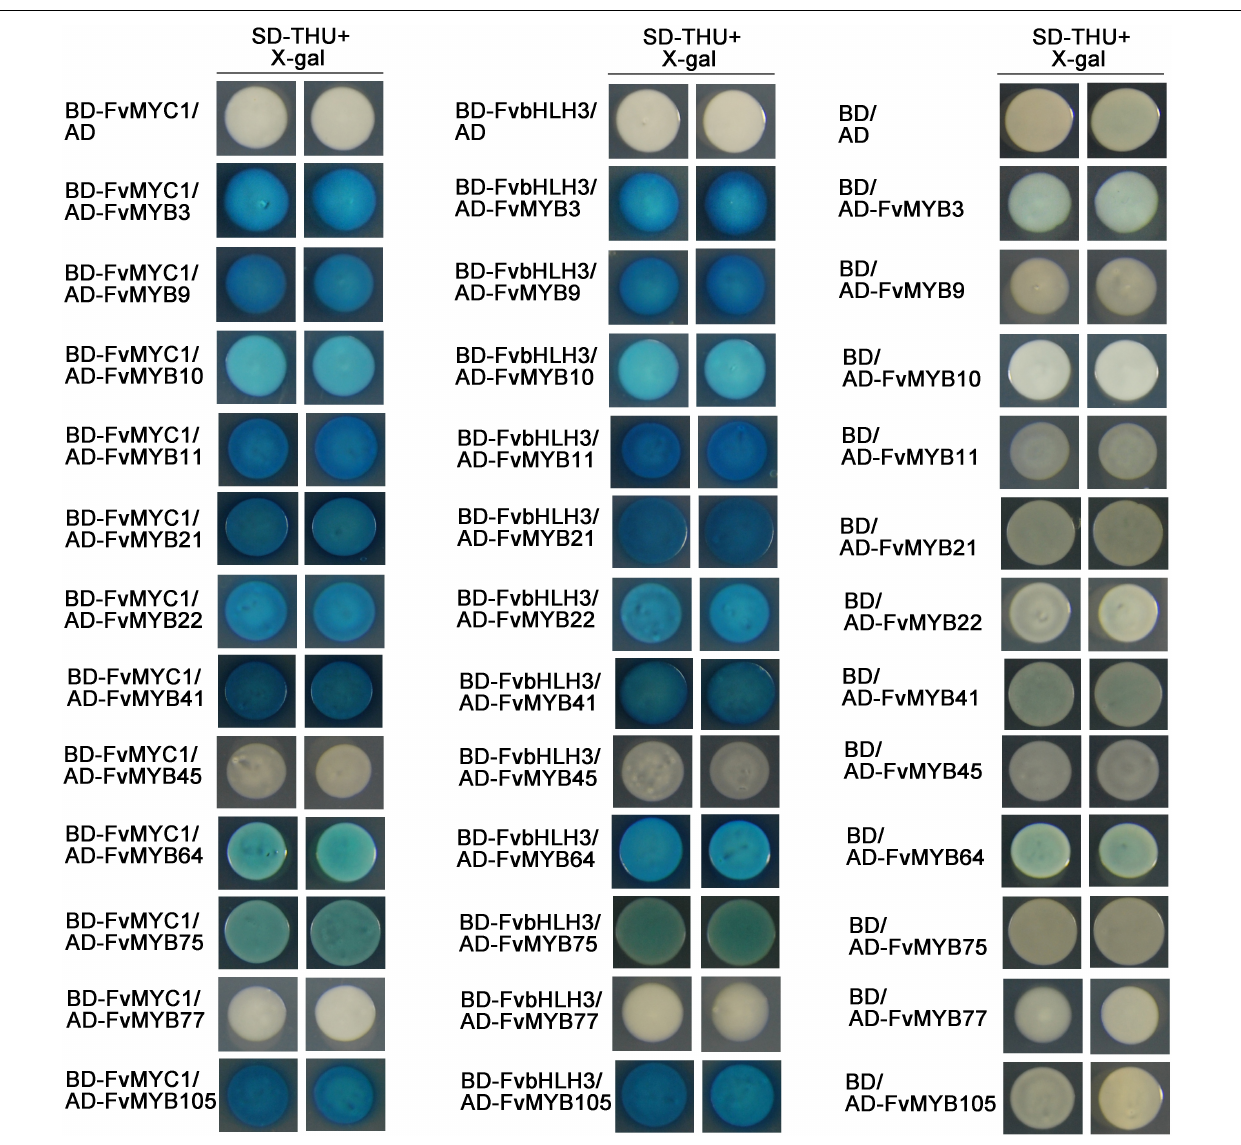
FIGURE 4 | The interaction of MYB and bHLH proteins in yeast cells. LexA yeast two-hybrid assays showing interactions between FvMYB proteins and FvbHLH proteins. Yeast cells were grown on selective medium (SD-Trp, -His, -Ura; SD-THU) with 80 mg/L X -gal. Blue precipitates represent cumulative β -galactosidase activity resulting from the activation of the LacZ reporter gene by interacting proteins. Two representative colonies were shown for each